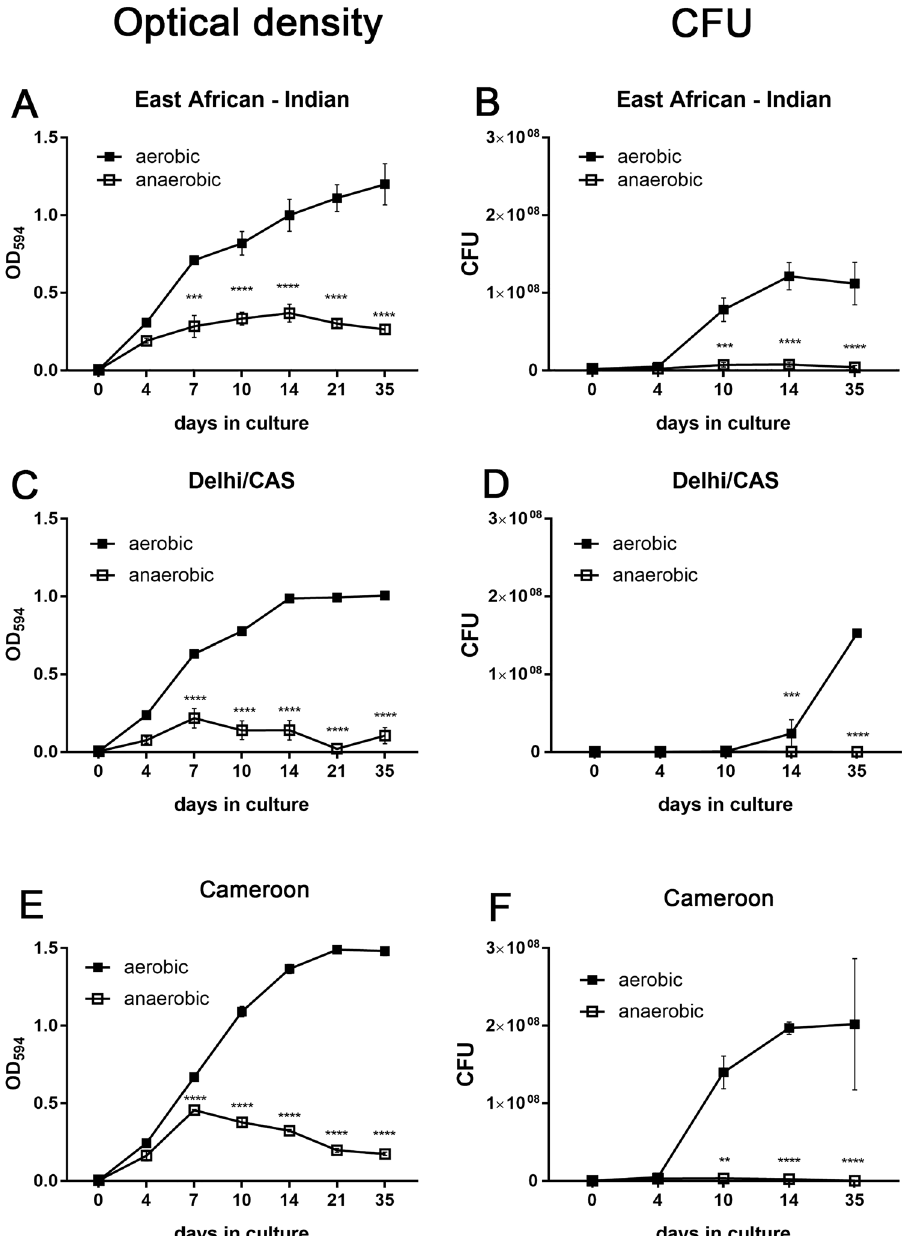
Figure 6. O 2 depletion induced dormancy in EAI (L1), Delhi/CAS (L3), and Cameroon (L4). Approximately 2 × 10 6 (OD = 0.004) mycobacteria were cultured with or without O 2 depletion. At indicated time points, OD was measured ( A , C , E ) or cultures were plated for CFU assay ( B , D , F ). O 2 depletion led to significantly reduced bacterial growth for all strains at indicated time points. *p < 0.05, **p < 0.005, ***p < 0.005, ****p < 0.0001, two- way